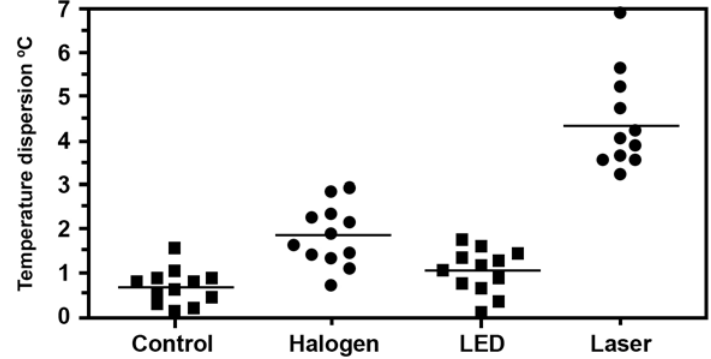
FIGURE 1- Temperature dispersion graph as a function on the